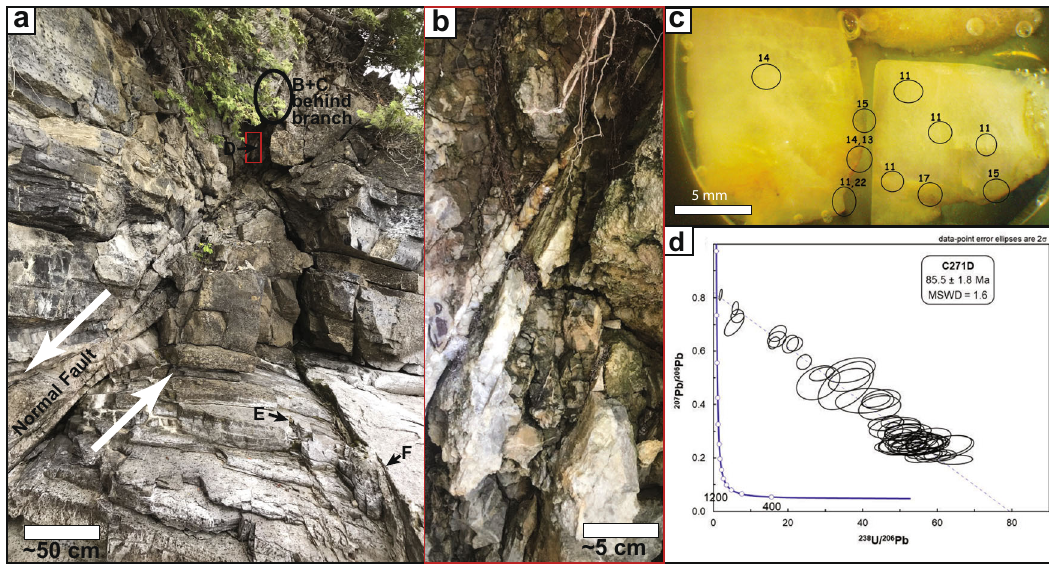
Fig. 4 Example study site. a Overview photo showing a top-to-the-east extensional fault zone at site 21a (Kingsland Bay State Park). The fault dips to the lower left corner of the photo (east) offsetting beds of Ordovician limestone. Six samples (A through F) were collected from this site, yielding ages from 79 to 88 Ma. Complete details and results from all sites can be found in source data fi les 1, 2. b Sample 271D was collected from tabular calcite within the fault zone. c Optical microscope photo of sample 271D annotated with the location of preliminary laser shots that showed high 238 U/ 206 Pb ratios. This image was used to target attractive areas of the crystal during subsequent analysis at UC Santa Barbara. d Isotopic ratios measured at UC Santa Barbara. Each ellipse represents a single laser shot on the same calcite sample. They de fi ne a mixing line (isochron) between shots with a higher concentration of initial common-Pb (to left) and shots with a higher concentration of radiogenic lead (to right). The dashed line shows the unanchored isochron line fi t to the data. Sample age is estimated based on its projected intersection with the thick blue concordia line, as computed by Isoplot